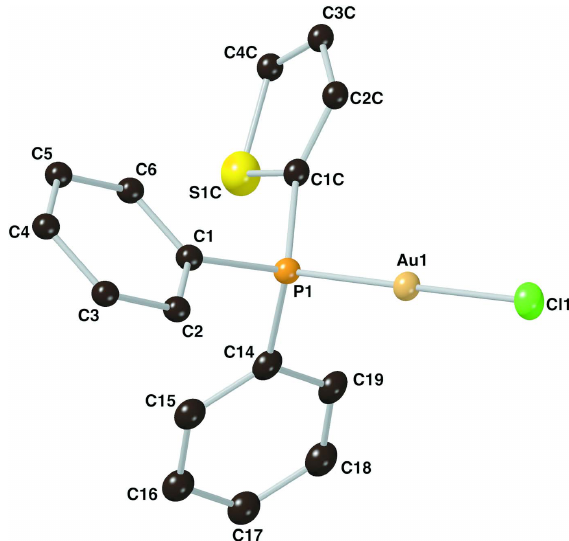
Figure 1 The molecular structure of the title compound I , with the atom-labeling scheme. Displacement ellipsoids are drawn at the 30% probability level, all hydrogen atoms have been omitted and only the predominant Part 1 is shown for clarity.